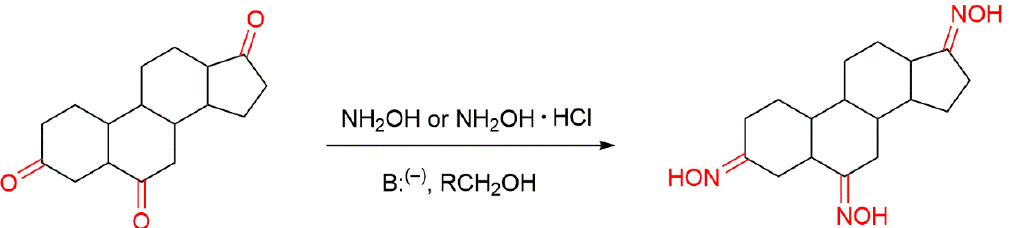
Figure 3. Classical synthesis of steroidal oximes which can take part in different positions in the steroidal scaffold.